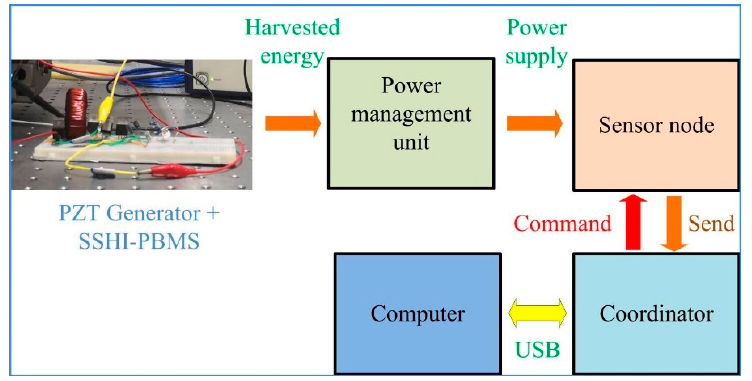
Figure 13. A potential application scenario with the proposed SSHI-PBMS